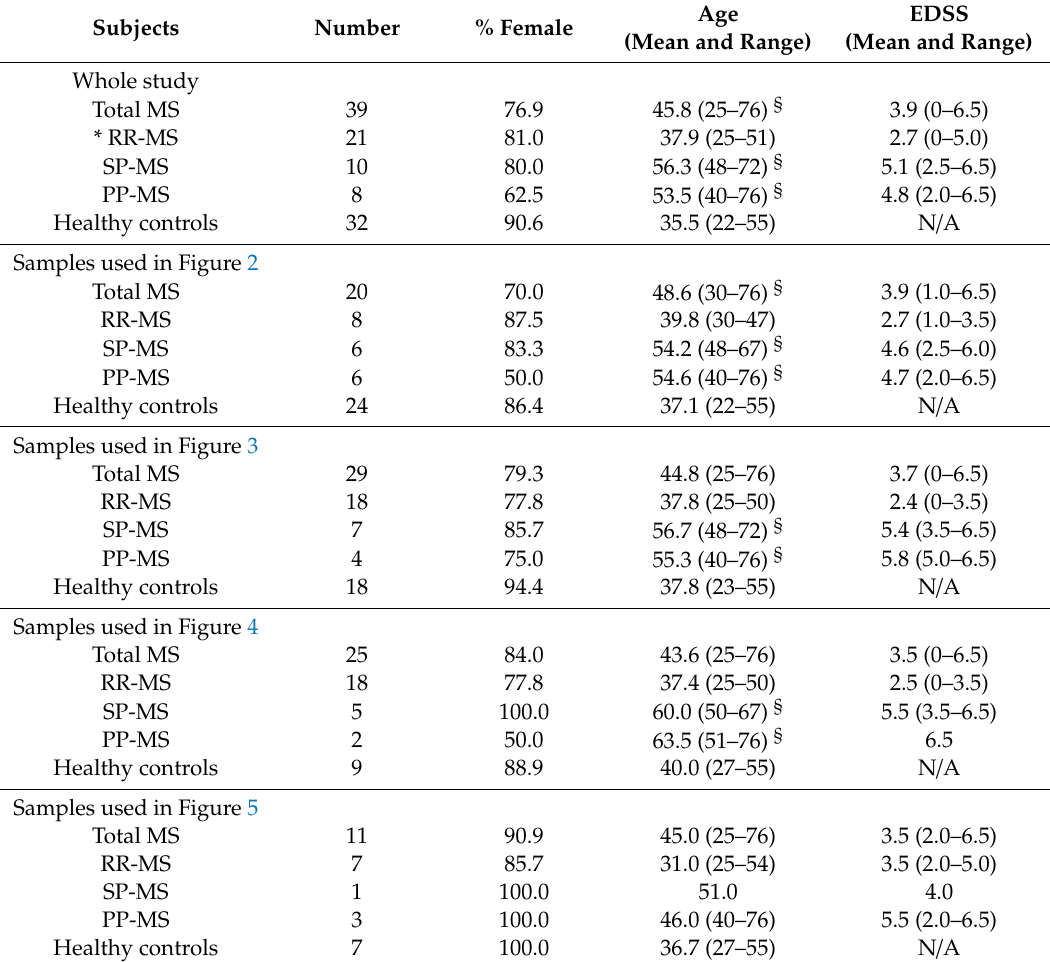
Table 1. Demographics of participants in the